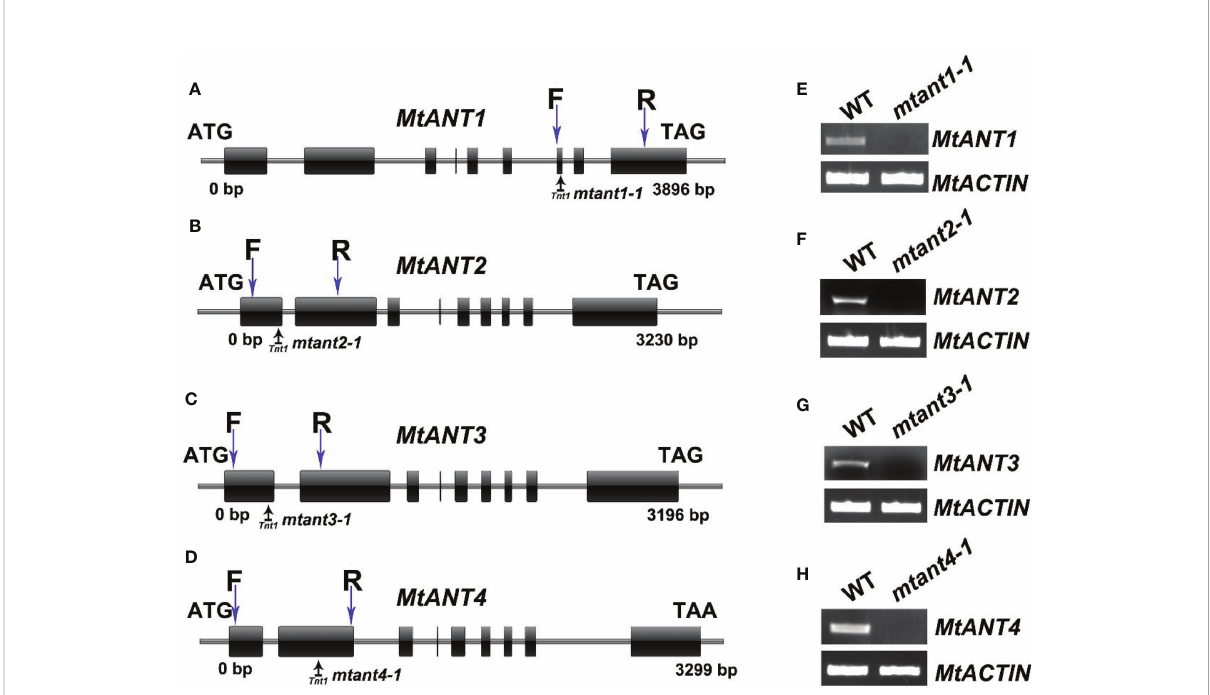
FIGURE 5 Mutant screening of MtANTs in M. truncatula . (A – D) Schematic diagram of the gene structures of MtANT1 - MtANT4 . The positions of the ATG start and TGA/TAA stop codons are shown. Black vertical arrows mark the location of Tnt1 retrotransposons. Blue vertical arrows mark the location of primers used for RT-PCR. Exon is represented by a box, and intron is represented by a line. (E – H) RT-PCR shows the transcripts of MtANTs in wild type and mtant mutants. MtACTIN was used as the